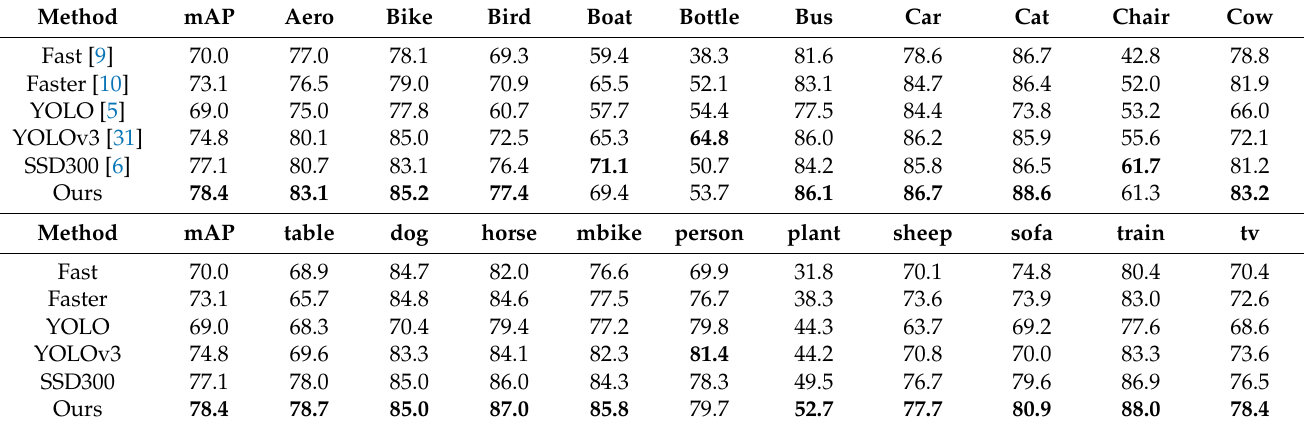
Table 5. The test detection result on PASCAL VOC2007.